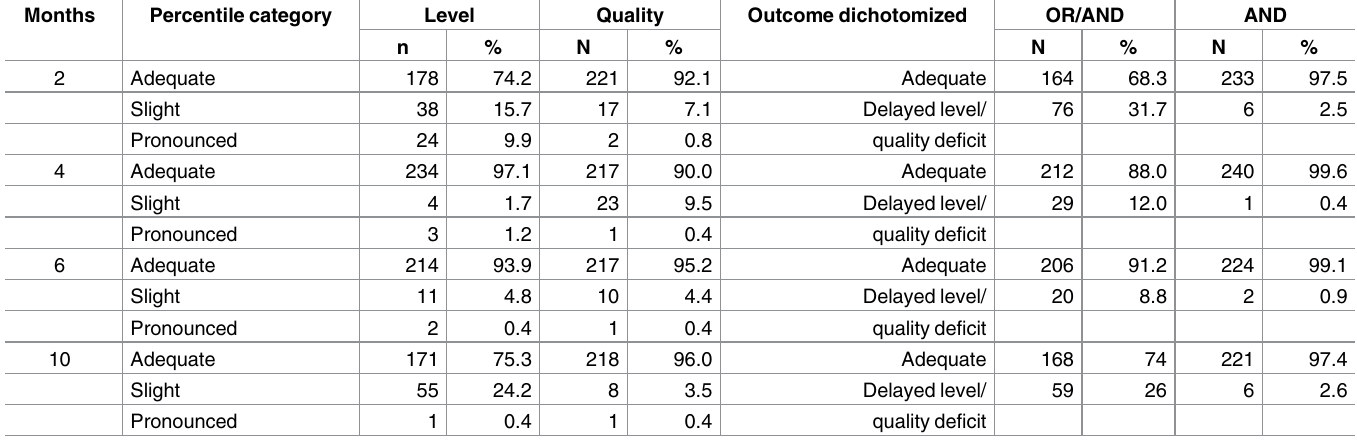
Table 2. The motor performance of 242 infants presented as number and percentages when assessed by child health nurses using Structured Observation of Motor Performance in